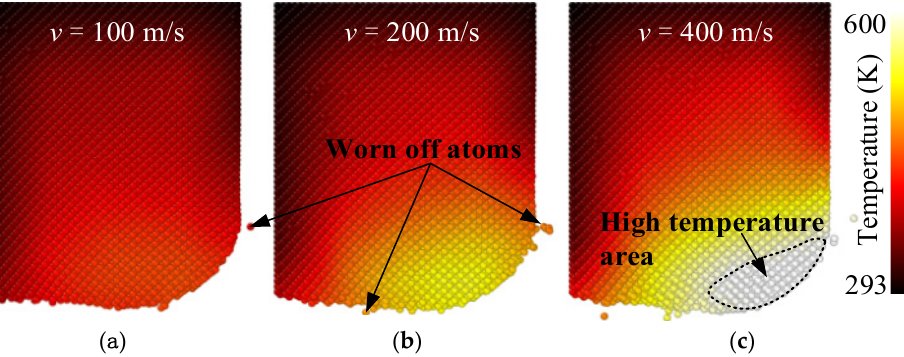
Figure 10. The effect of cutting speed on the temperature distribution of the diamond tool. The cutting speed was ( a ) 100 m/s, ( b ) 200 m/s and ( c ) 400 m/s,